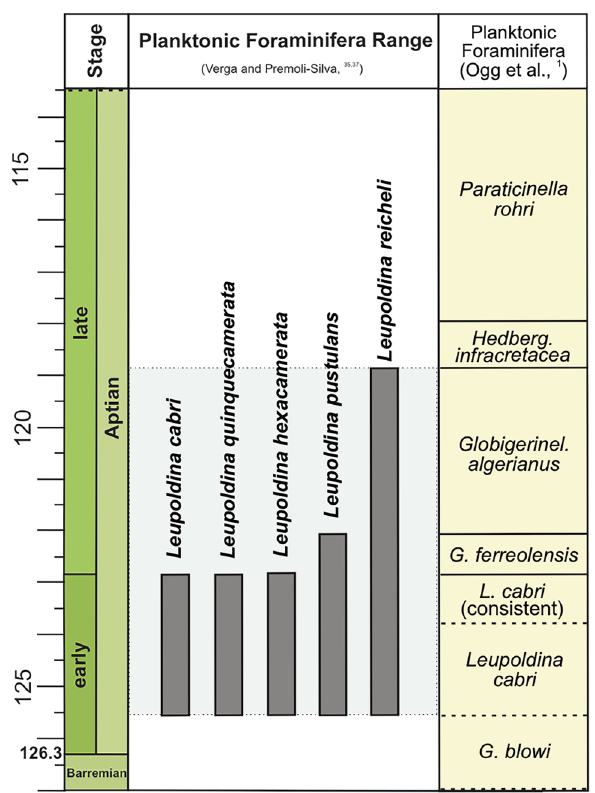
Figure 6. Planktonic foraminifera zonation scheme for the late Barremian–Aptian interval. Planktonic foraminifera range is taken from Verga and Premoli-Silva 35,37 (adapted from Ogg et al. 1 ). Graphic art made with CorelDRAW Graphics Suite × 6, version 16.0 (https:// www. corel draw.